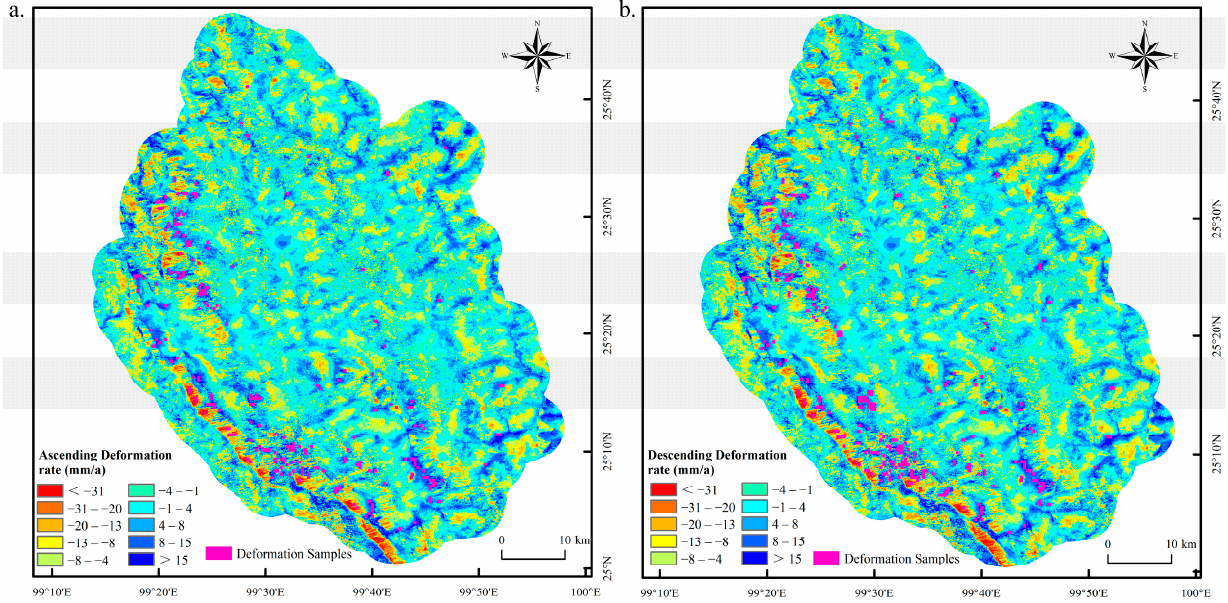
Figure 5. InSAR deformation rate map and 16 × 16 sample selection. ( a ) Ascending deformation rate with deformation samples, ( b ) Descending deformation rate with deformation samples.